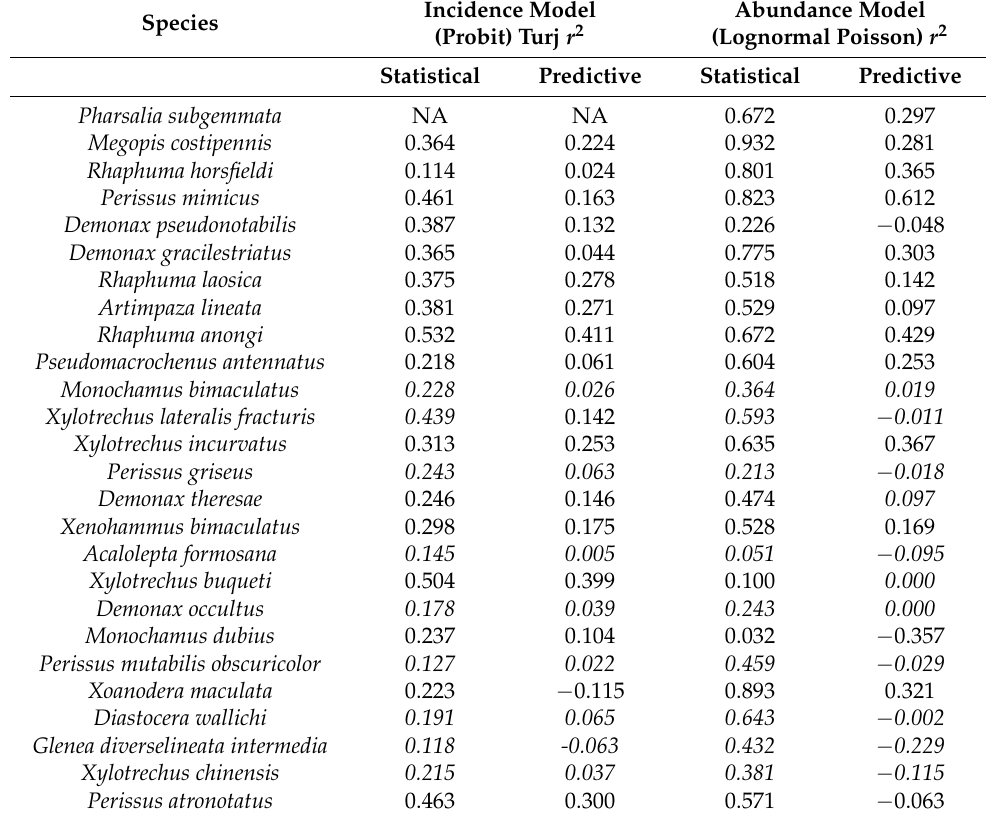
Table 3. Model performance for the Hierarchical Modelling of Species Communities (HMSC). We used the predictive r 2 , which was based on a five-fold cross validation, to determine model performance. Species with values in italics were not well predicted in either model. Note that Pharsalia subgemmata saturated the traps such that an incidence model could not be